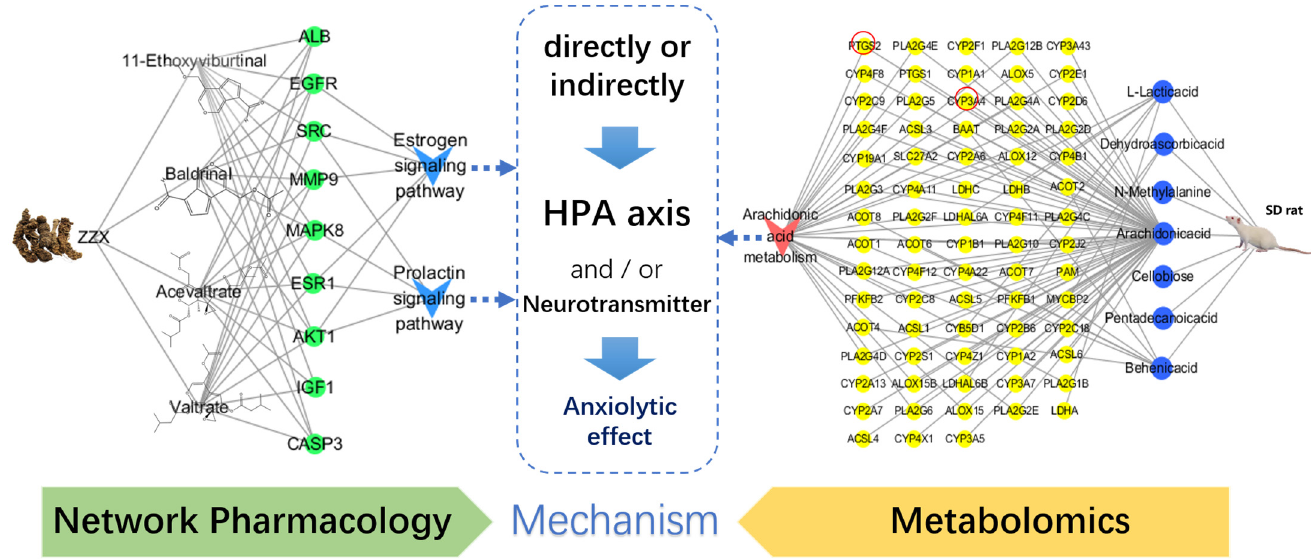
Figure 9. An illustration of the target-signaling-pathway-regulatory index–metabolite regulatory network.